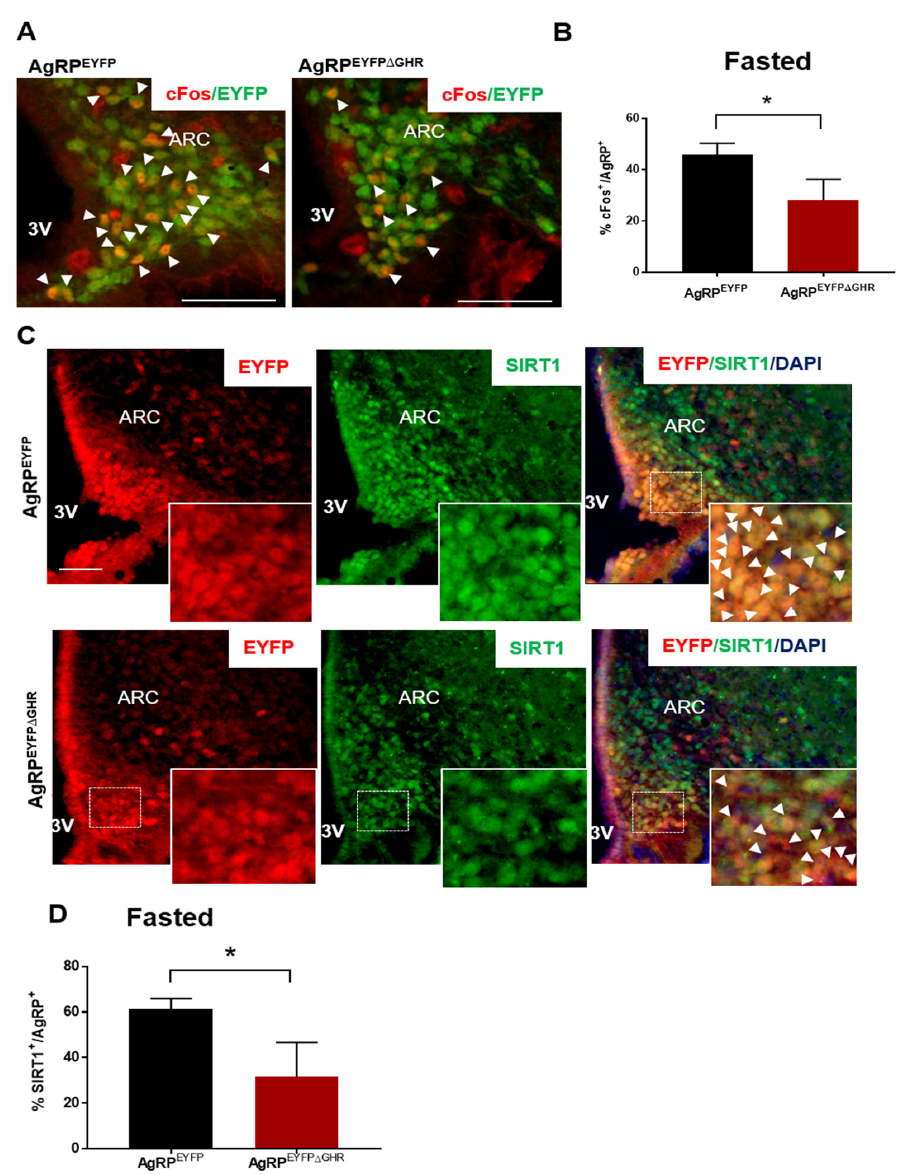
Figure 3. Blunted responses of SIRT1 to fasting in AgRP EYFP ∆ GHR mice. ( A ) Representative image and ( B ) quantification of 18 h fasting-induced c-fos (red) co-localized with AgRP neurons (red) in AgRP EYFP ∆ GHR and control mice. ( C ) Representative images of the hypothalamic ARC sections of AgRP EYFP and AgRP EYFP ∆ GHR female mice fasted for 18 h. Red, AgRP + EYFP neurons; green, SIRT1; the merged images show co-localization of AgRP and SIRT1 in the ARC. Scale bar: 100 µm. The magnified images on the bottom show the co-localization of AgRP and SIRT1 fluorescence. ( D ) The percentage of SIRT1 + cells from AgRP + neurons in the ARC. The arrows show co-localization. Data are shown as mean ± SEM. *, p < 0.05 ( n = 3– 4).